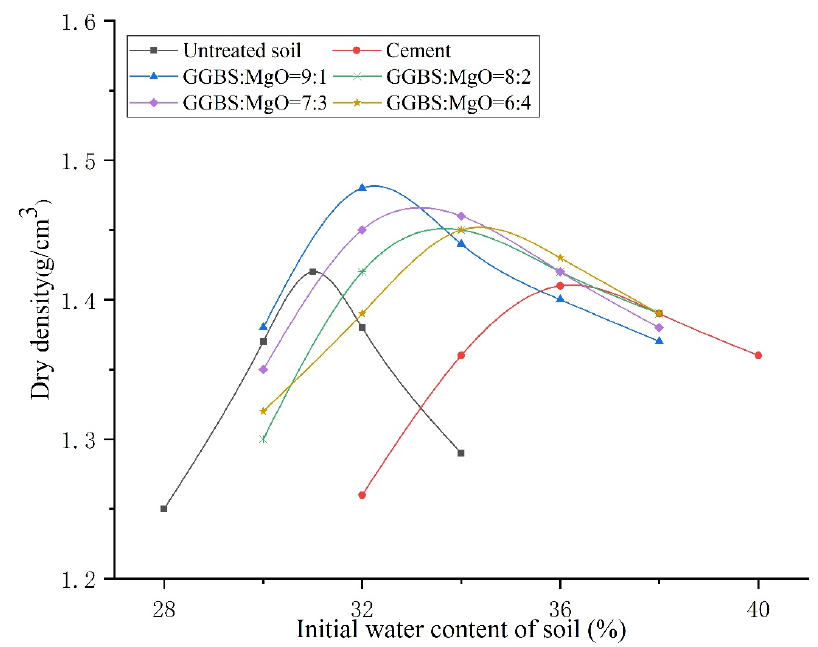
Figure 1. Compaction curves of Ca-sulfate-soil with and without curing agents.